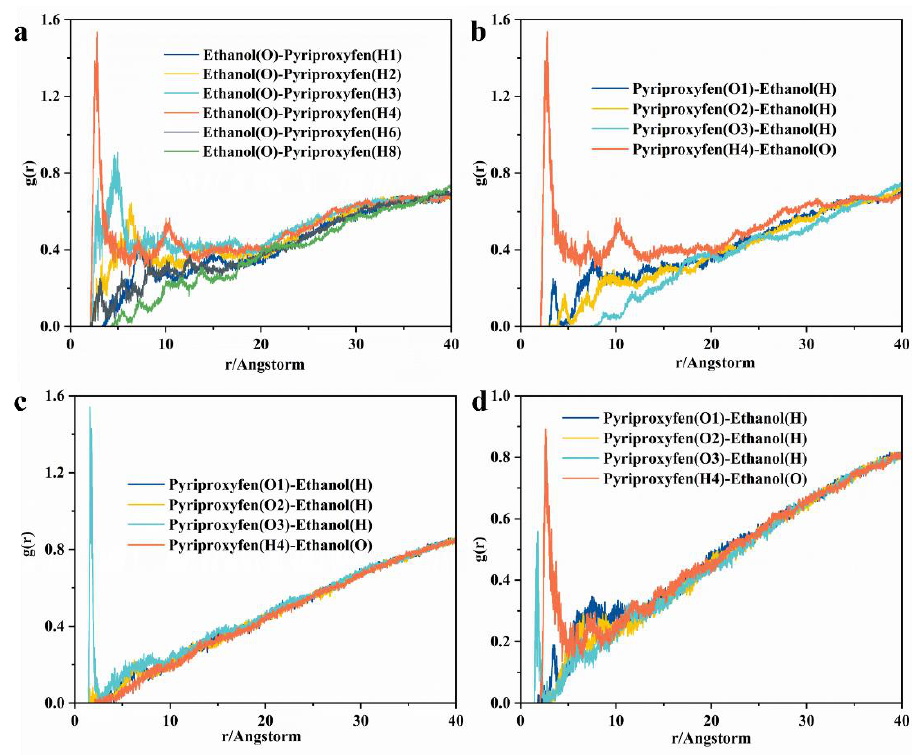
Figure 7. RDFs of pyriproxyfen in crystal layer and ethanol. ( a ) RDFs of the ethanol (O) to different pyriproxyfen (H) on (002) crystal layer; ( b ) RDFs of the ethanol around the interfacial layers of (002); ( c ) RDFs of the ethanol around the interfacial layers of (102); ( d ) RDFs of the ethanol around the interfacial layers of (111).